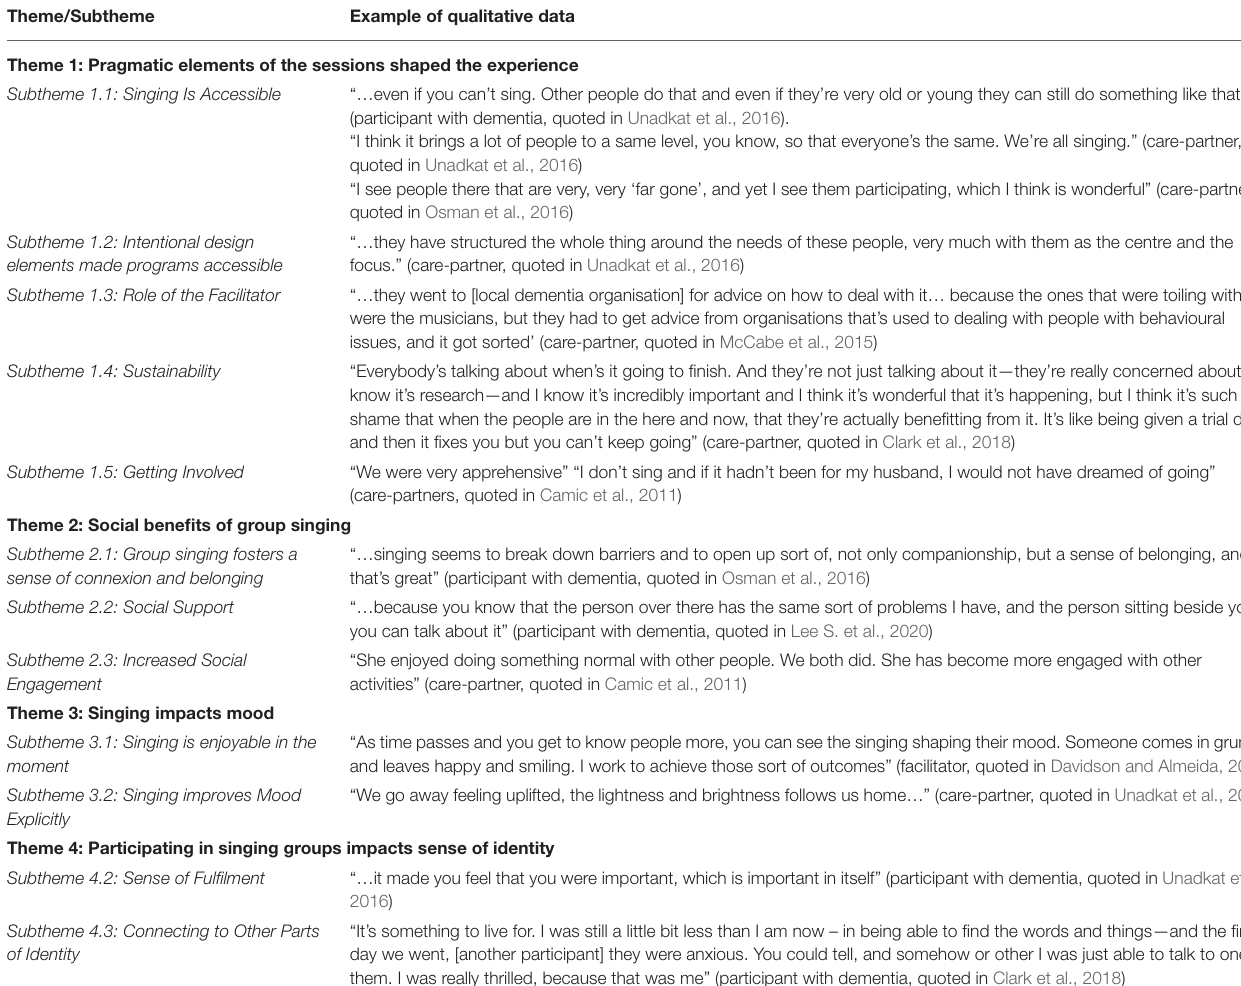
TABLE 10 | Examples for qualitative themes and subthemes.